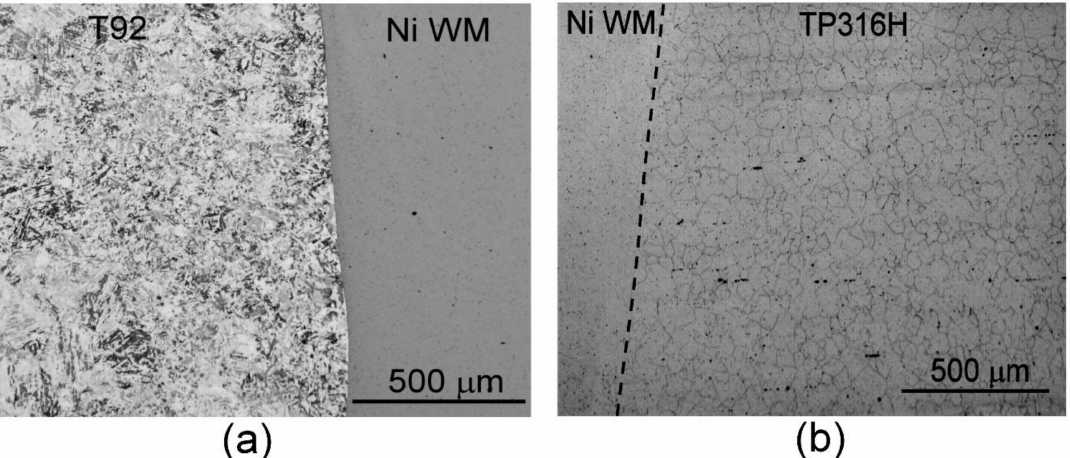
Figure 4. The general view on individual microstructural regions of T92/TP316H dissimilar weldment with Ni-based weld metal: T92/Ni WM region ( a ); Ni WM/TP316H region ( b